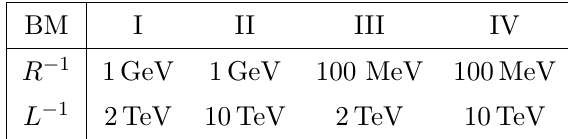
Table 1 . The di(cid:11)erent sets of parameters used in BM for the present